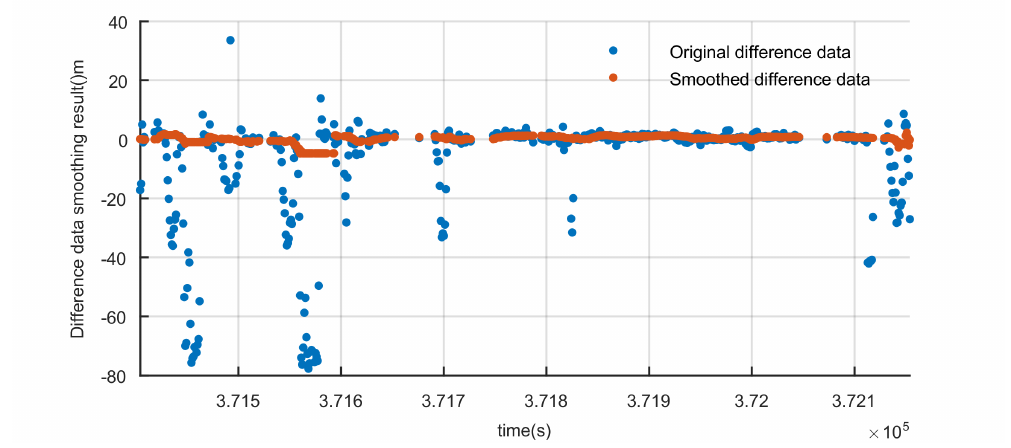
Figure 7. Difference data smoothing